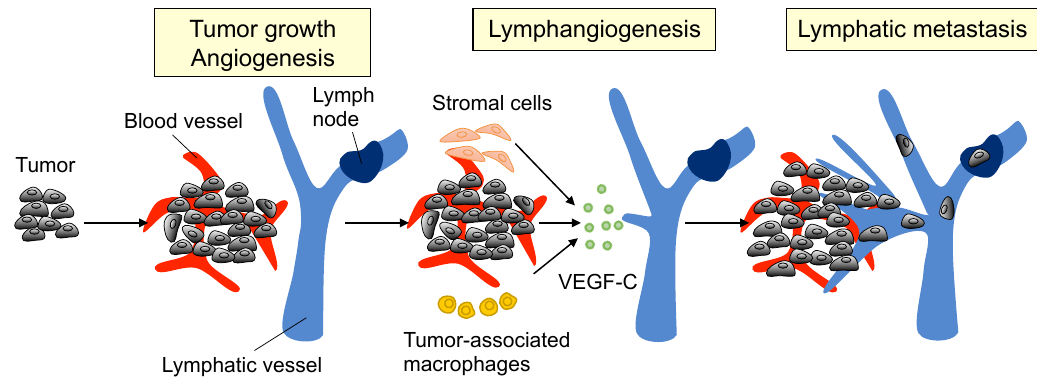
Figure 1. Tumor lymphangiogenesis. The primary tumor, as well as stromal cells and tumor-associated macrophages, release vascular endothelial growth factor-C (VEGF-C) to initiate tumor lymphangiogenesis. Once VEGF-C activates lymphatic endothelial cells (LECs) by binding to VEGFR-3, the cells proliferate and migrate to form new lymphatic vessels in the primary